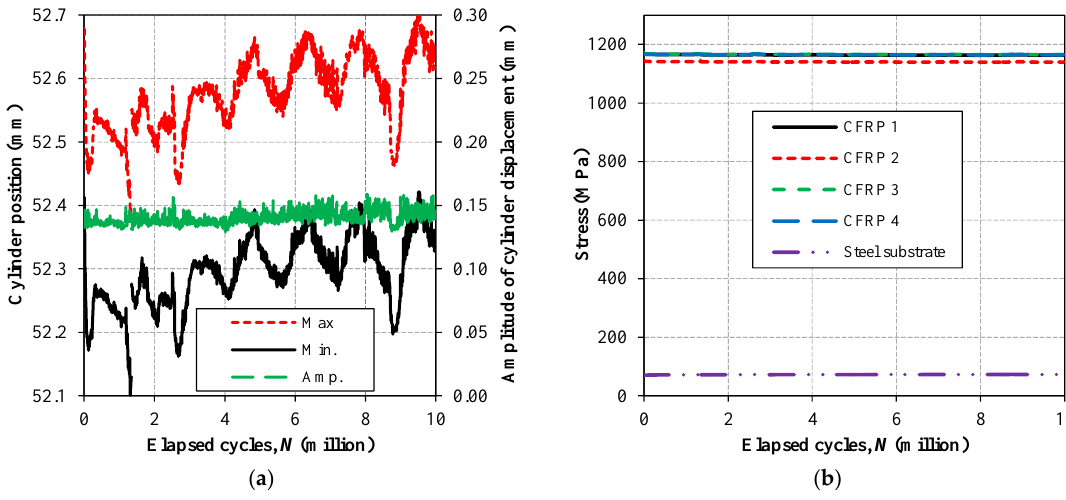
Figure 8. ( a ) Evolution of cylinder position during fatigue test; and, ( b ) evolution of maximum stress in CFRP plates and steel substrate in response to fatigue cycles.